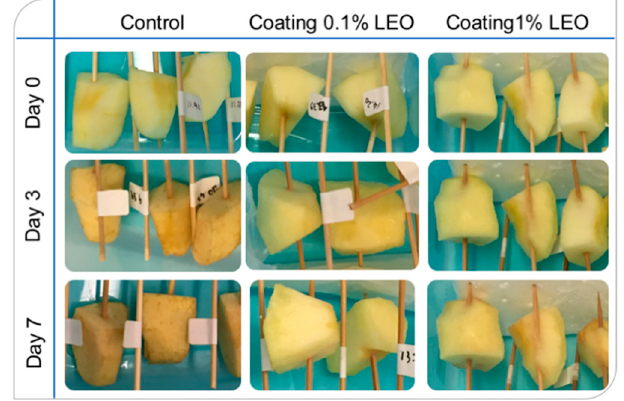
Figure 6. Appearance of the fresh-cut apples subjected to different treatments during storage at 4 °C.